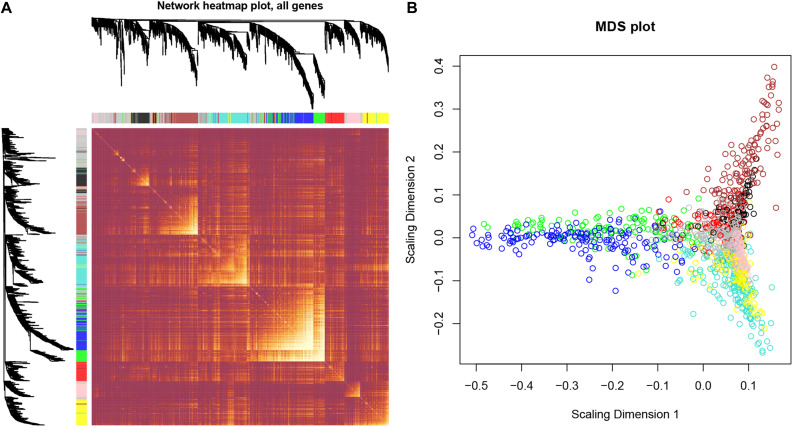
Interaction relationship analysis of co-expression genes and construction of a classical MDS plot. (A) Different colors of horizontal axis and vertical axis represent different modules. The brightness of yellow in the middle represents the degree of connectivity of different modules. There was no significant difference in interactions among different modules, indicating a high-scale independence degree among these modules. (B) Classical MDS plot whose input is the TOM dissimilarity. Each dot (gene) is colored by the module assignment.